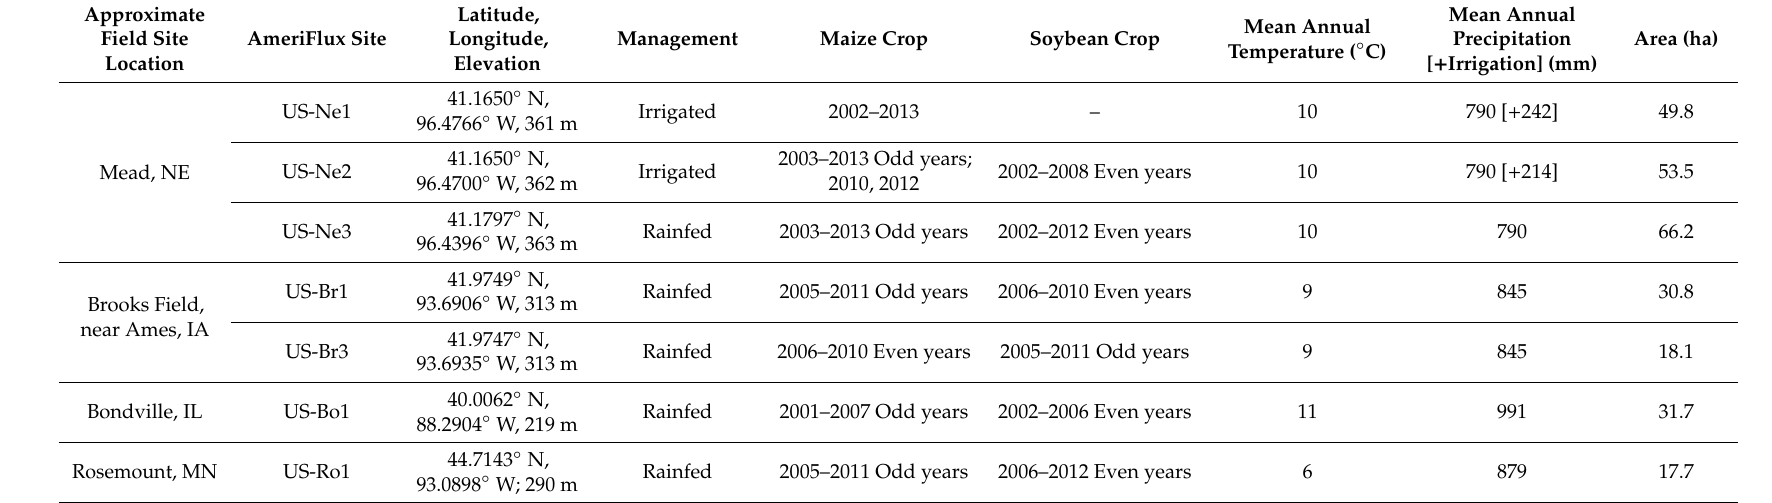
Table 1. AmeriFlux study site locations, management status, crop rotation, field years, mean annual temperatures, precipitation, and field area information. Coordinates and area determined from WGS 84 (EPSG:4326)